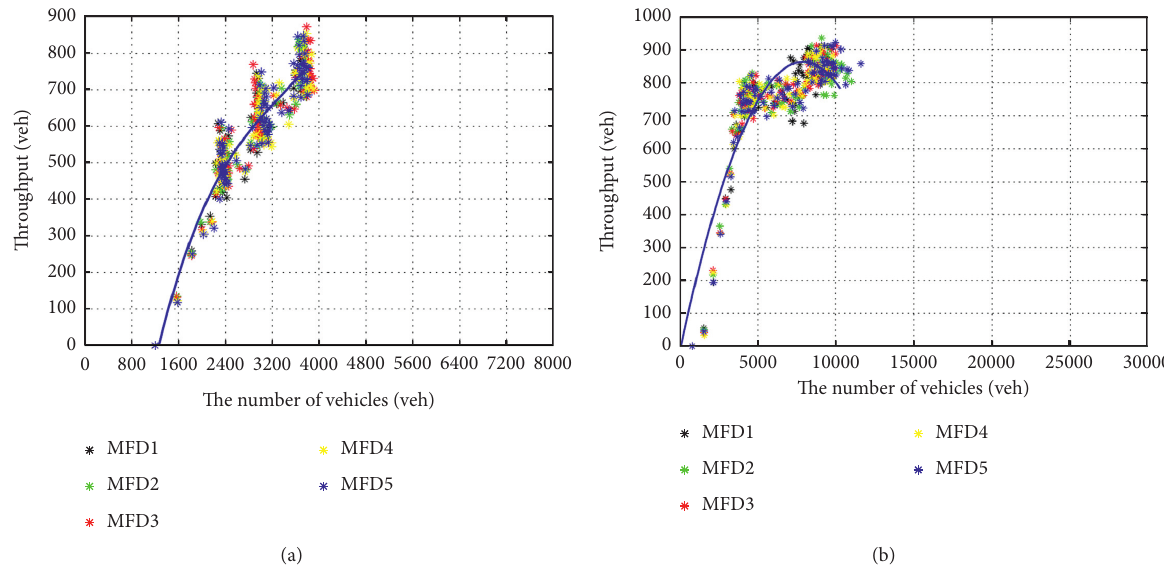
Figure 10: The throughput of a 4 × 4 network reported by Yan et al. [45] for scenarios 1 and 2. This result is presented here to compare with the proposed method. (a) The proposed traffic light phasing reported for the scenario 1. (b) The proposed traffic light phasing reported for the scenario 2.